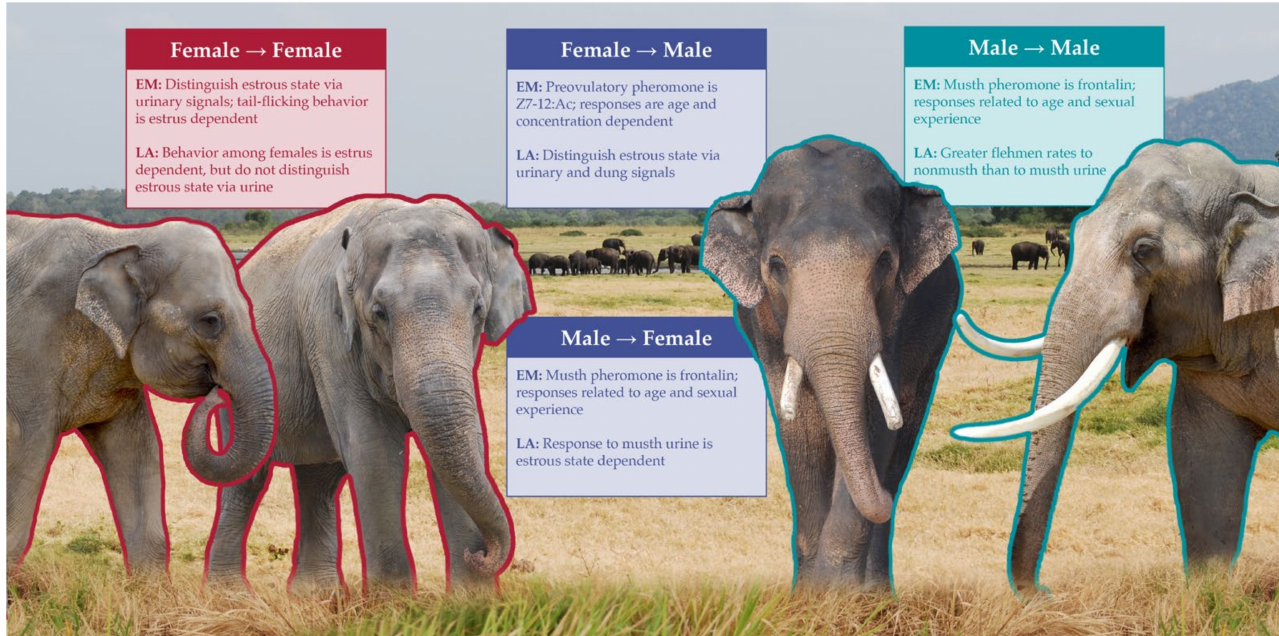
Figure 2. Summary of 21st-century findings in intraspecific chemical signaling among elephants. EM = Elephas maximus , the Asian elephant. LA = Loxodonta africana , the African savanna elephant. Red indicates female–female signals, blue indicates male–male signals, and purple indicates intersexual